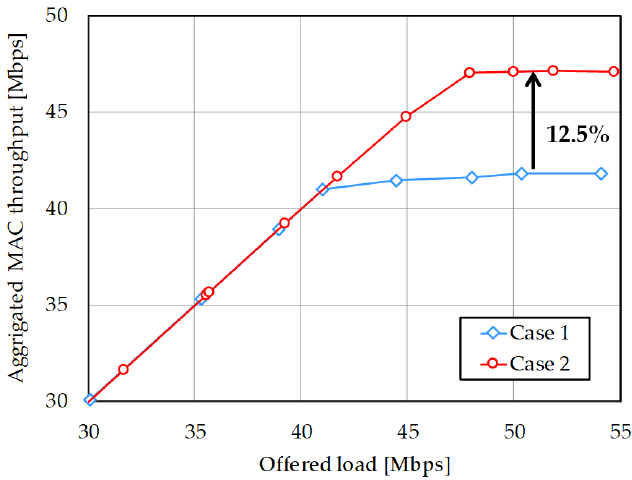
Figure 5. Aggregated MAC level throughput in simplified topology. Table 3. Saturated throughput values in simplified topology.